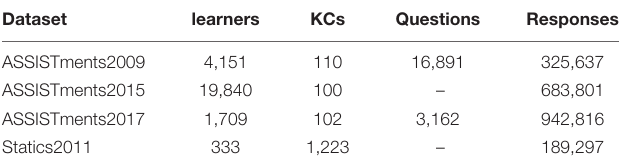
TABLE 1 | Statistics of